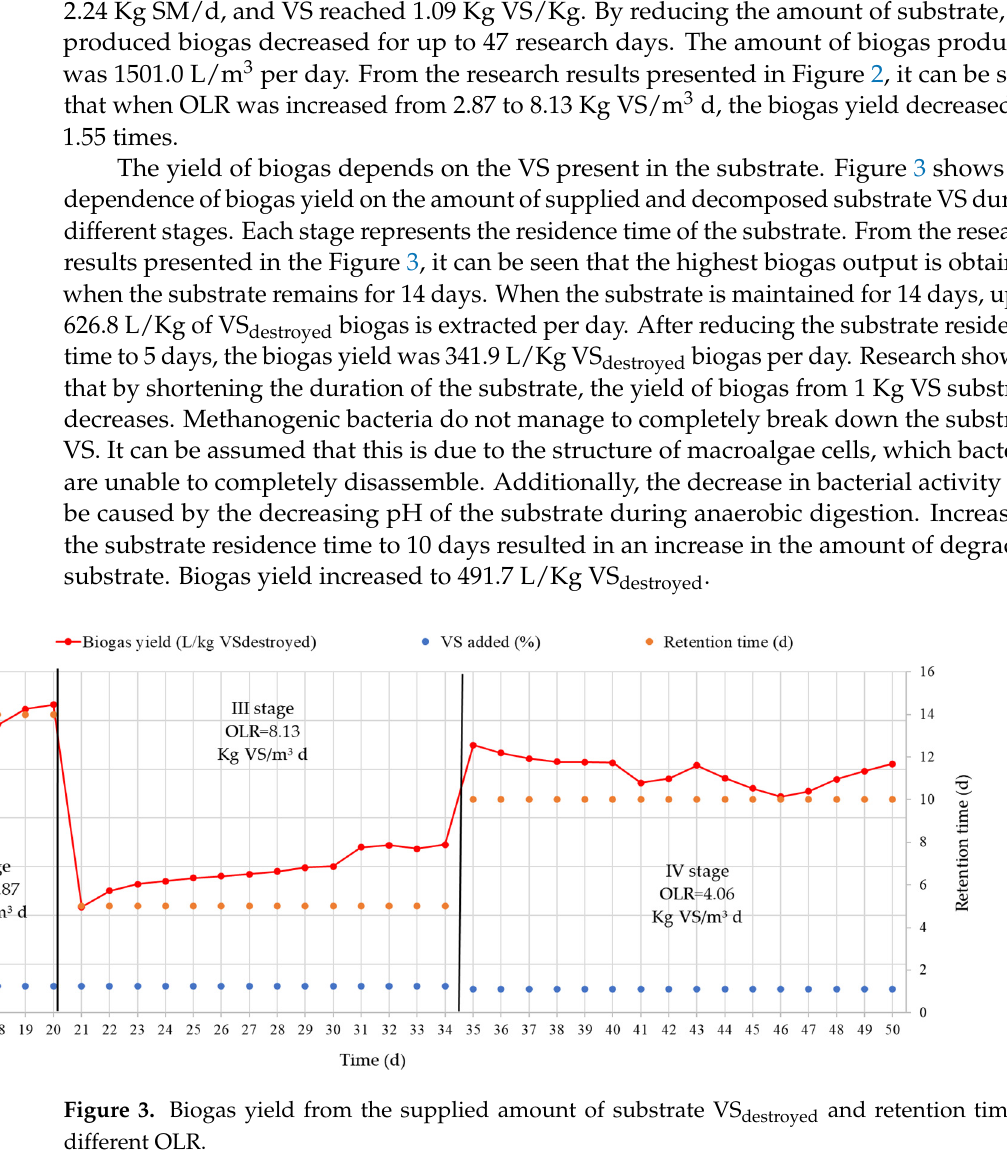
Figure 2. Dependence of biogas production on residence time and OLR.